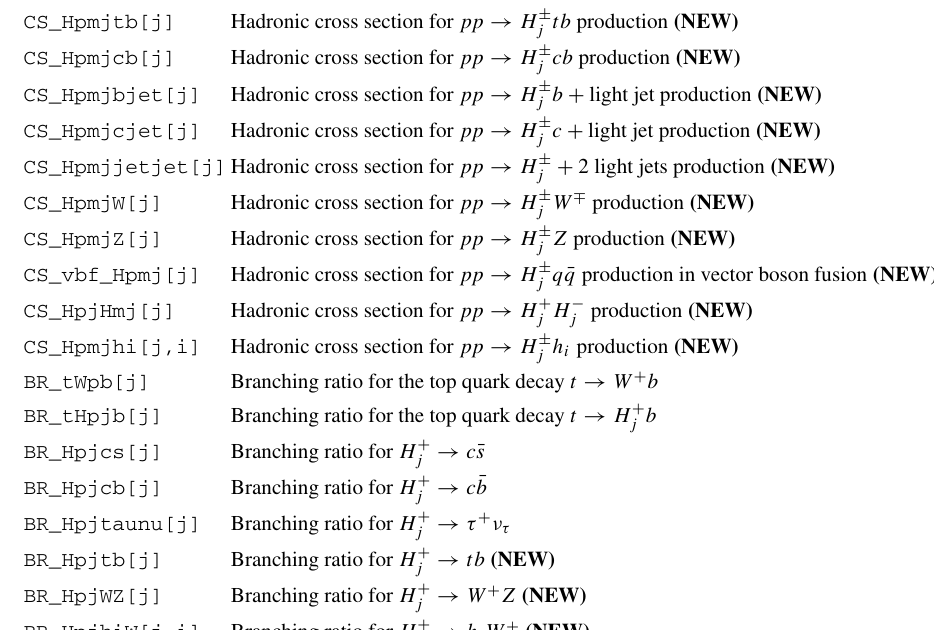
Higgs boson production cross sections (in pb), top quark branching ratios, and branching ratios for charged Higgs